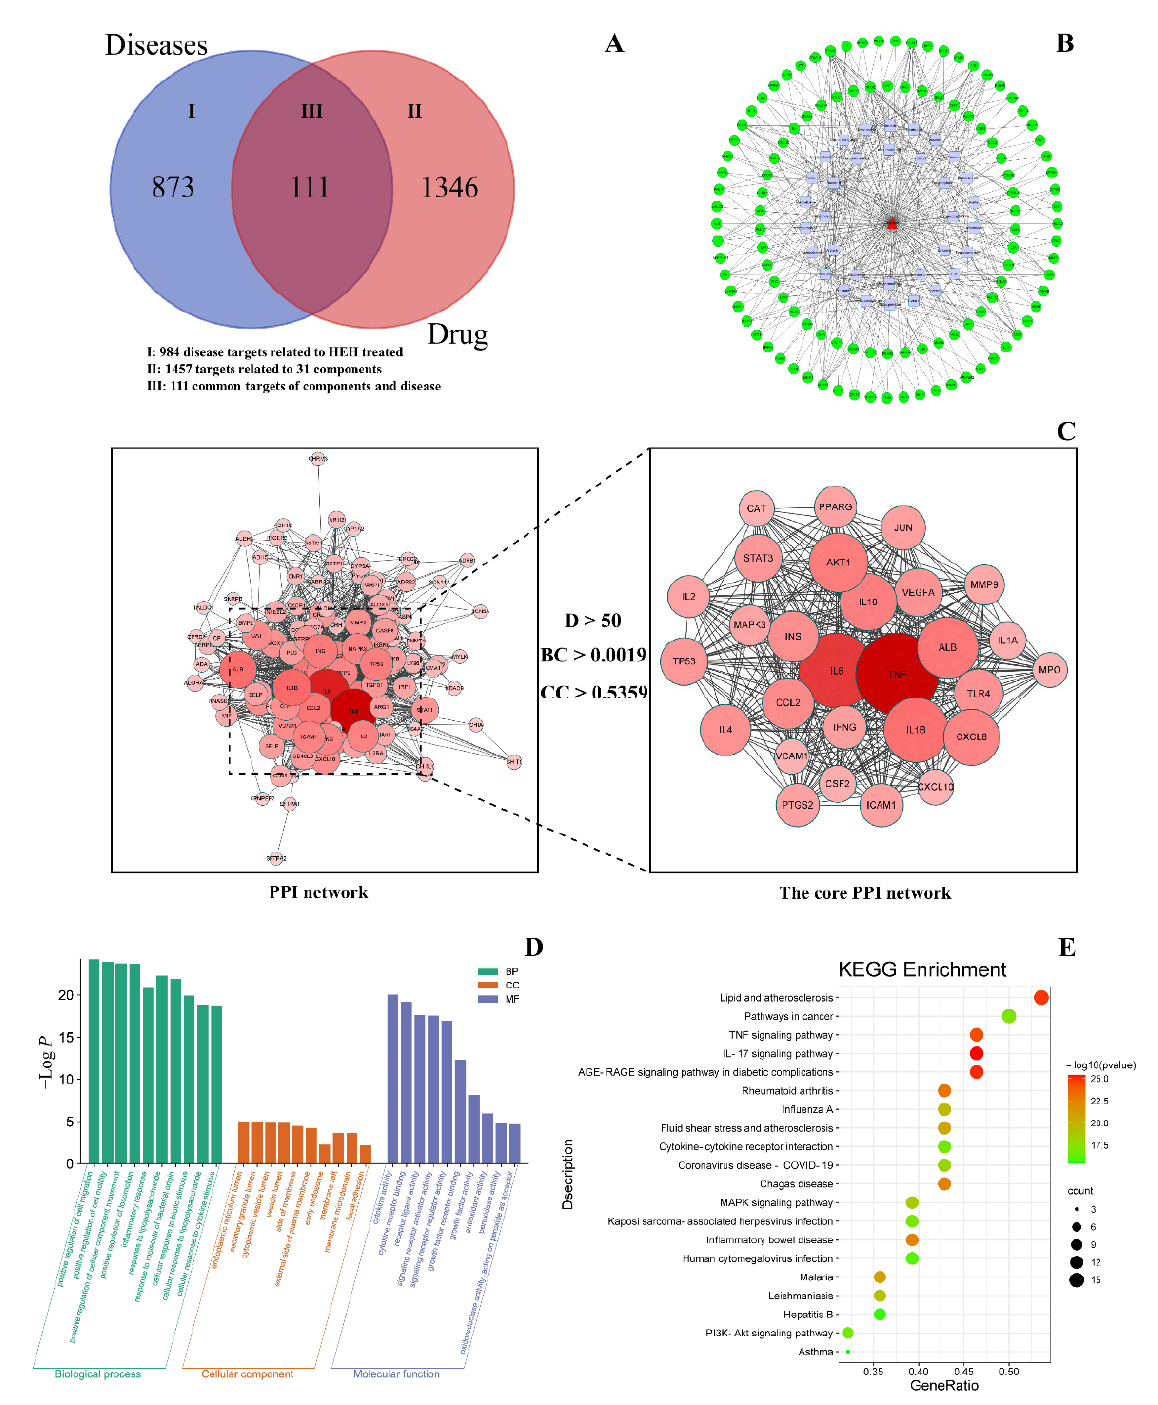
Figure 4. ( A ) Venn diagram of differential chemical markers and intersection targets; ( B ) component-disease-target network; ( C ) PPI network; ( D ) secondary classification histogram of GO functional enrichment analysis. The abscissa shows the GO term, and the ordinate shows the number of genes enriched in the GO term; ( E ) bubble diagram of the KEGG pathway enrichment analysis results. The abscissa shows the ratio of the number of targets genes belonging to a pathway to the total number of annotated genes located in the pathway. The ordinate shows the pathway term. The bubble size indicates the number of targets in the pathway. The bubble color represents the magnitude of the p -value. The redder the color, the smaller the p -value, and the higher is the degree of